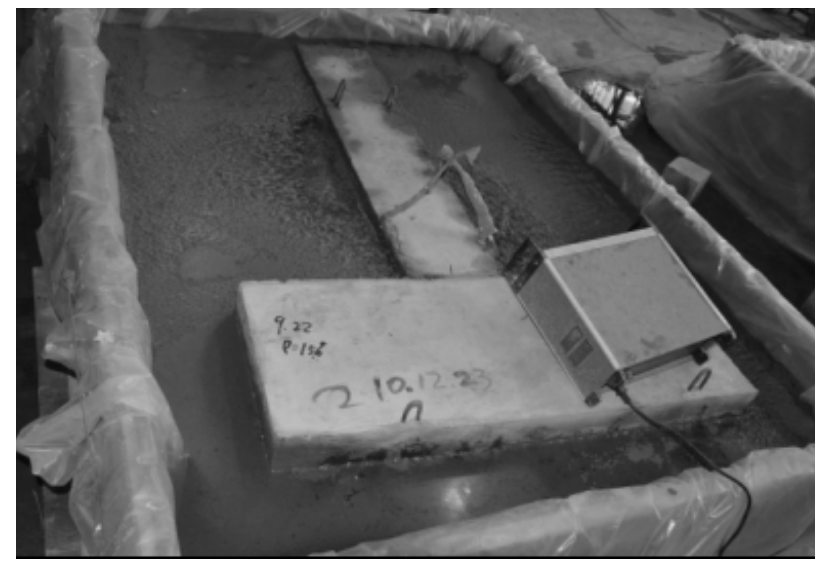
Figure 2. The accelerated corrosion of